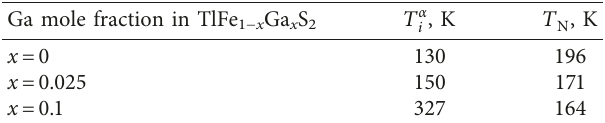
Table 1: The inversion point of thermopower sign ( T α i ) and ) versus the composition of temperature of phase transition ( T N TlFe Ga x S solid 1 − x 2